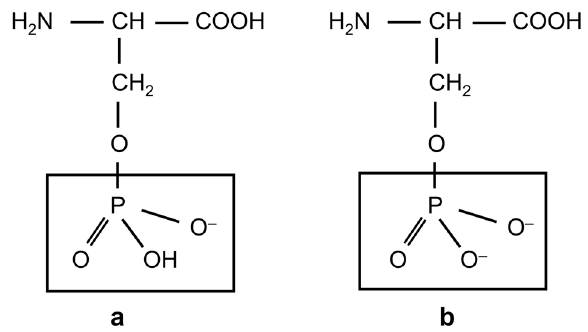
Fig. 9 Molecular structures for ( a ) singly and ( b ) doubly charged